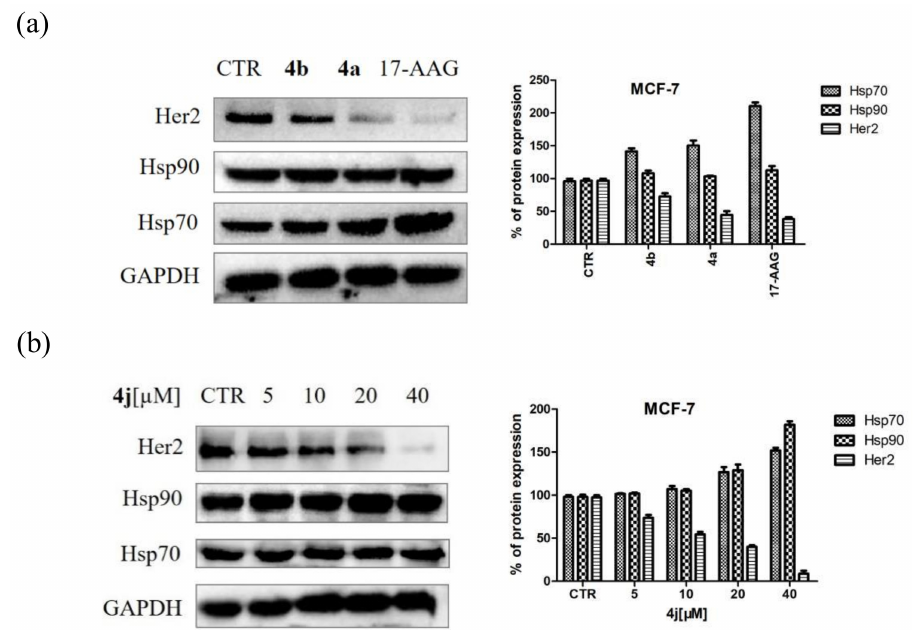
Figure 5. Western blotting assay. ( a ) E ff ects of 17-AAG, 4a , and 4b on the expression of Her2, Hsp70, and Hsp90 in the MCF-7 cell line. Glyceraldehyde 3-phosphate dehydrogenase (GAPDH) was used in a loading control. ( b ) E ff ects of compound 4j (0, 5, 10, 20, and 40 µ M) on the expression of Her2, Hsp70, and Hsp90 in the MCF-7 cell